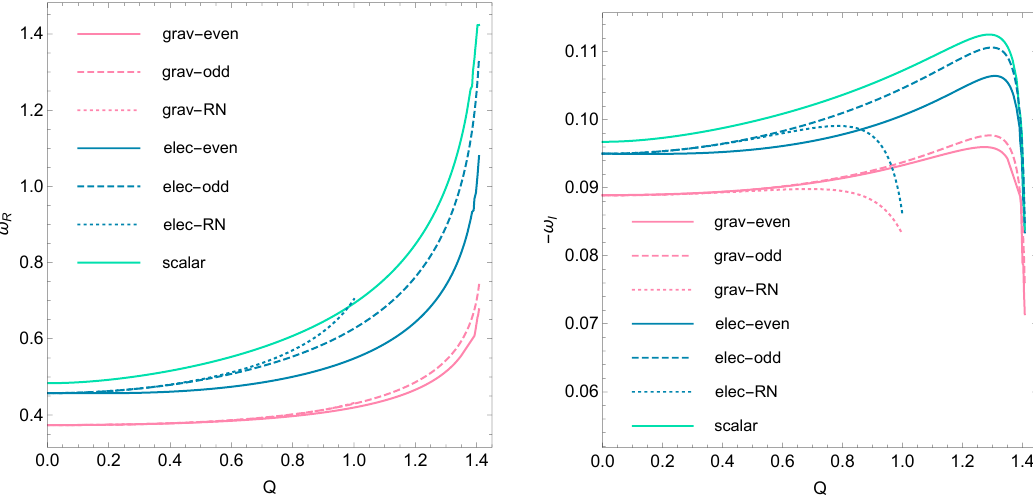
Figure 1 . Fundamental mode (lowest QNMs) for the EMd black hole as a function of the charge Q in units M = 1 and for ‘ = 2 . In pink, we have the modes associated to the gravitational sector, which reduce to the Regge-Wheeler and Zerilli potentials. In blue, the QNM associated to the electromagnetic sector and finally in blue the mode associated to the scalar field. These perturbations are compared to the Reissner-Nordstrom black hole in dotted line. The QNM have been calculated with a step size of 0 . 0025 for the